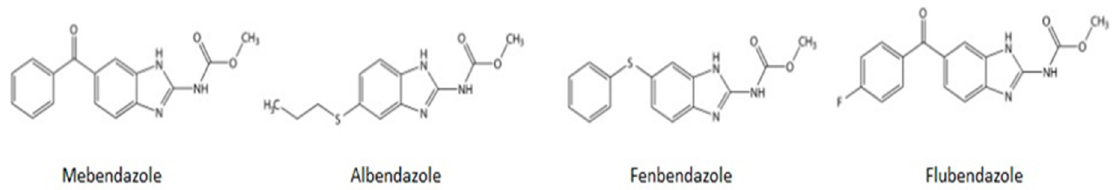
Figure 1. Chemical structures of benzimidazole anthelmintics commonly prescribed for human (mebendazole and Albendazole) and veterinary (Fenbendazole and Flubendazole) use.